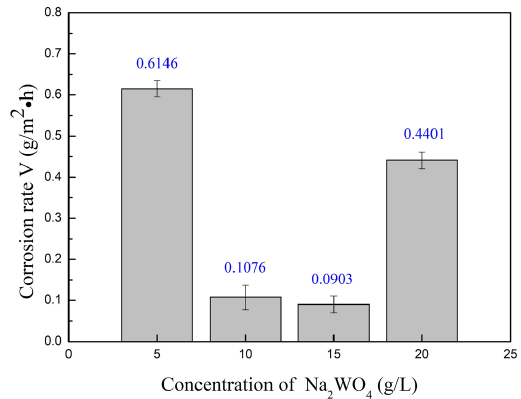
Figure 12. Corrosion morphologies of Ni-W-P coatings with different Na 72 h. (a) 5 g/L (b) 10 g/L (c) 15 g/L (d) 20